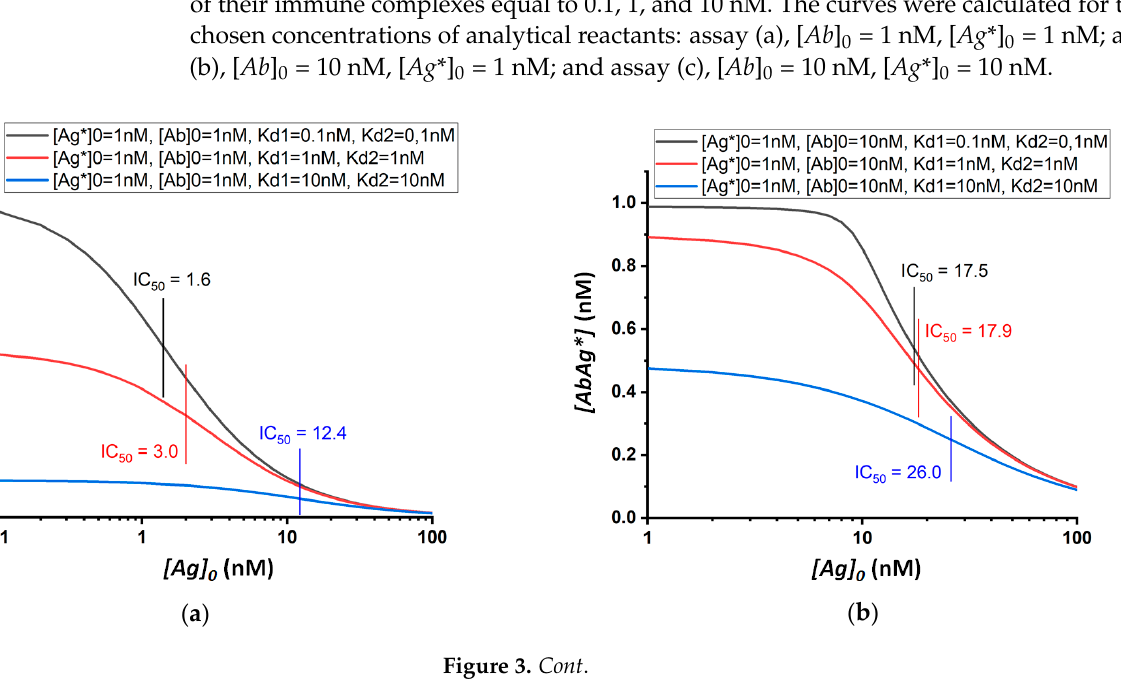
Figure 2. Theoretical calibration dependences of equilibrium competitive immunoassay at different values of the initial concentrations of the labeled antigen and antibodies.